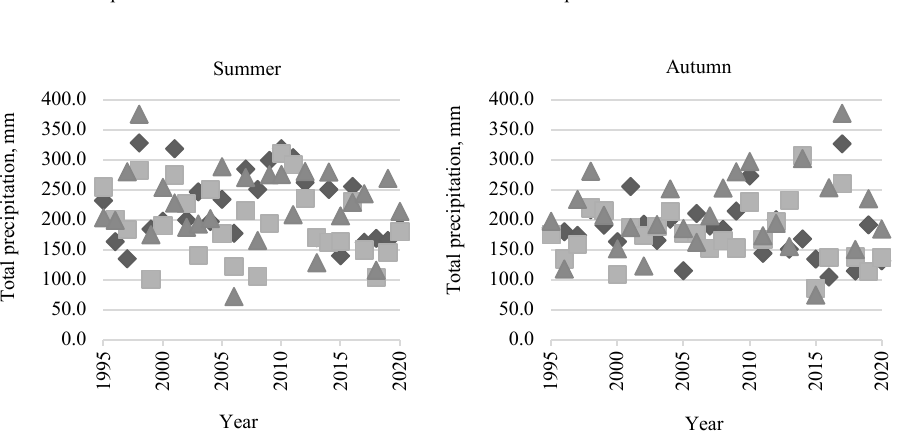
monitoring site 91 mm, in the Mellupite monitoring site 111 mm, and in the Vienziemite monitoring site 127